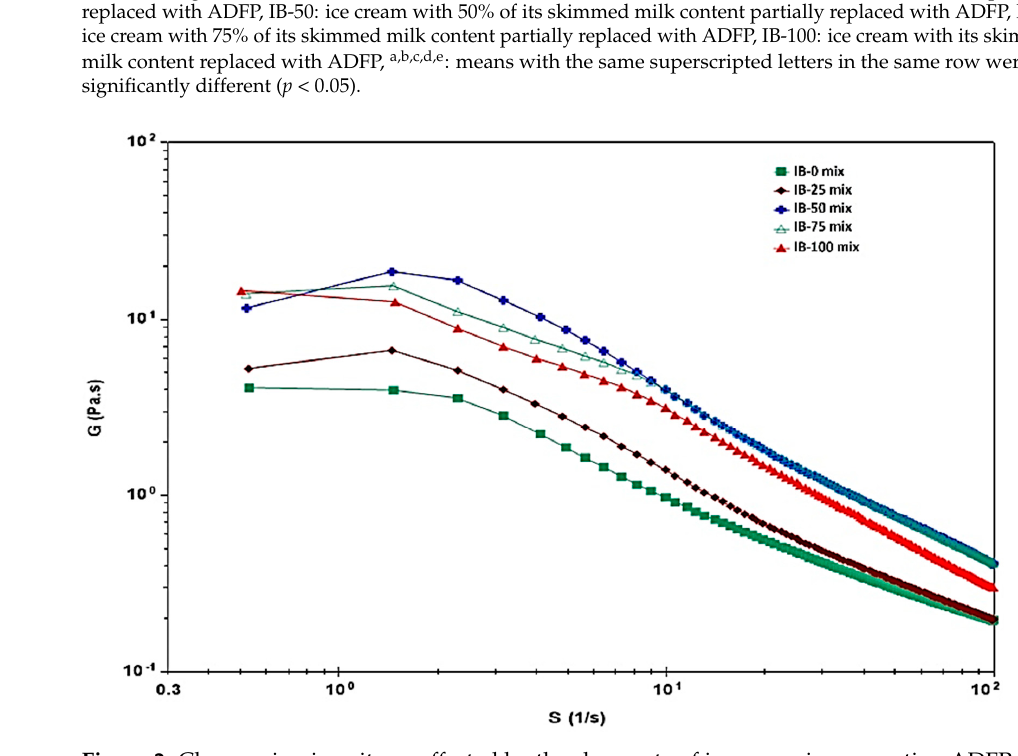
Figure 2. Changes in viscosity as affected by the shear rate of ice cream incorporating ADFP. IB-0: control ice cream, IB-25: ice cream with 25% of its skimmed milk content partially replaced with ADFP, IB-50: ice cream with 50% of its skimmed milk content partially replaced with ADFP, IB-75: ice cream with 75% of its skimmed milk content partially replaced with ADFP, IB-100: ice cream with its skimmed milk content replaced with ADFP. Table 8. Rheological properties (mean ± SD) of ice cream incorporating ADFP.